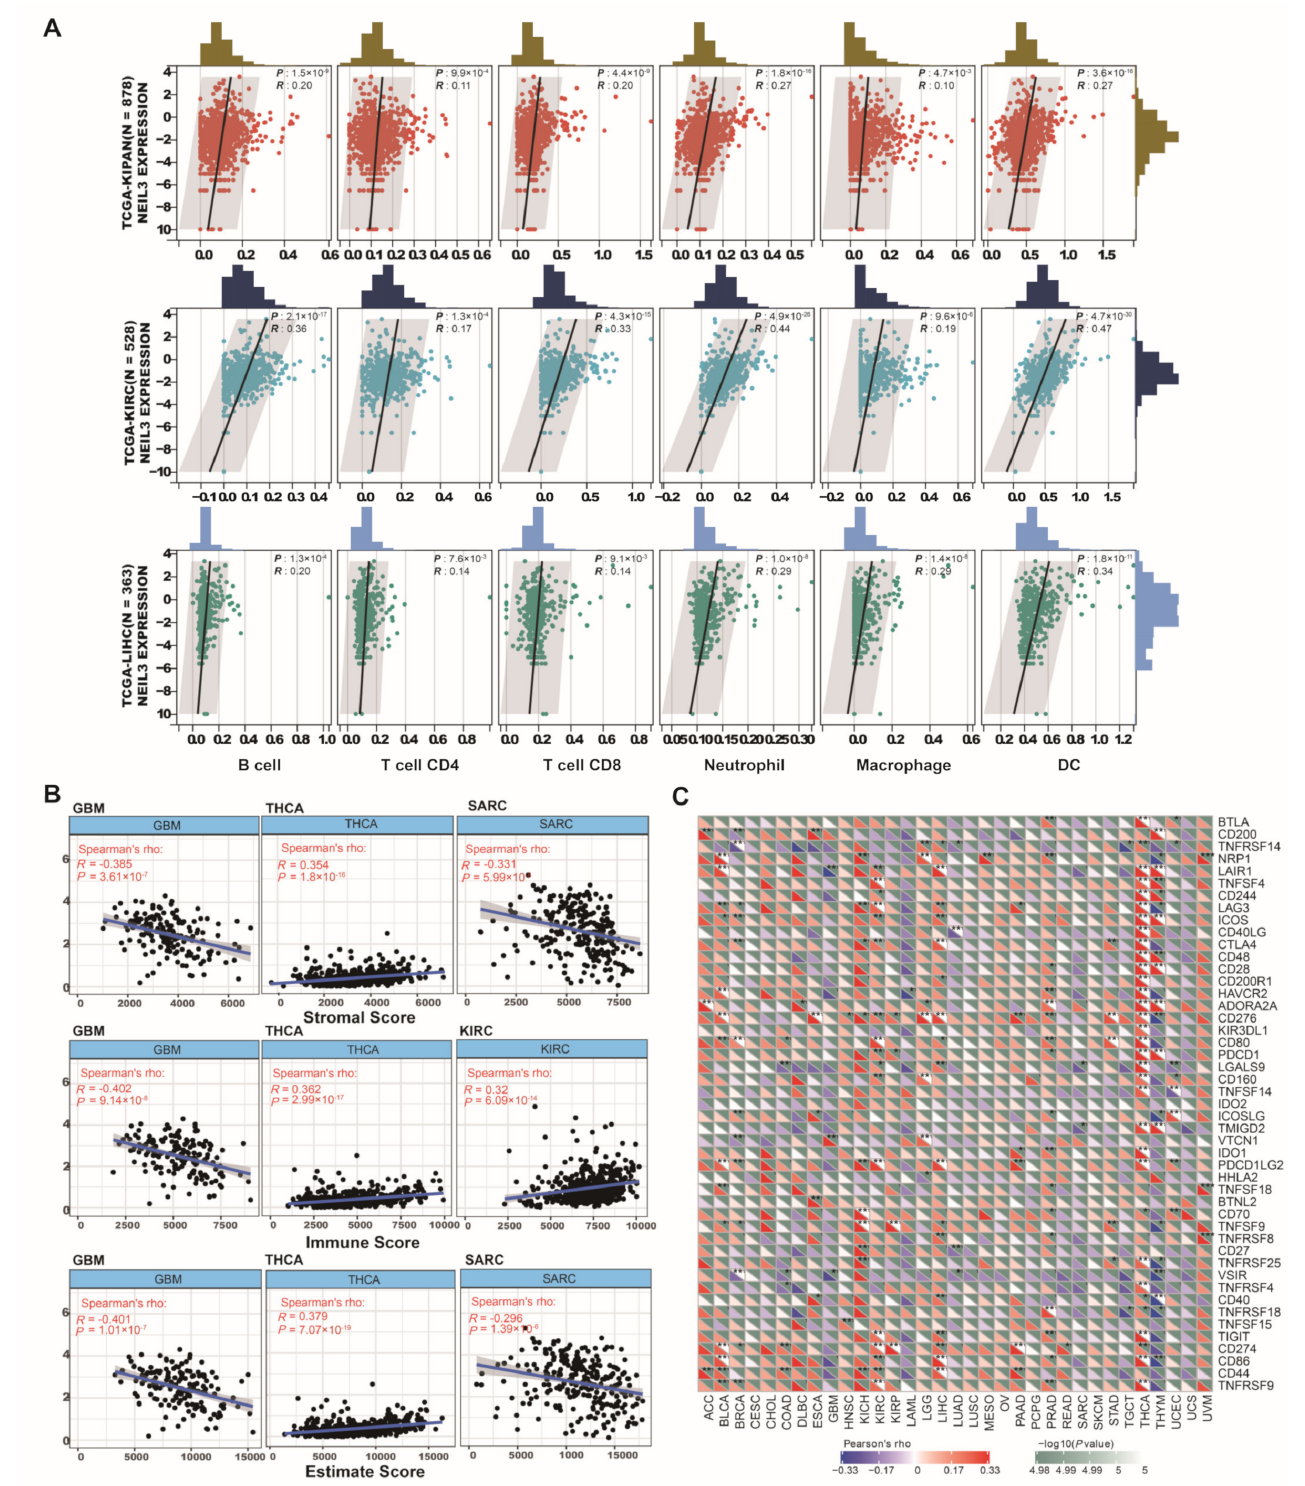
Figure 6. NEIL3 expression level is correlated with immune characteristics in cancers. Correlation between the expression level of NEIL3 and ( A ) lymphocyte infiltration in KIPAN, KIRC, and LIHC; ( B ) stromal score, immune score, and ESTIMATE score of the top 3 cancers; and ( C ) 40 common immune checkpoint genes across cancers. * p < 0.05, ** p < 0.01, *** p < 0.001. Immune checkpoint inhibitors (ICIs), as ever-expending agents, occupy an essential position in cancer immunotherapy [25]. Therefore, the correlation between NEIL3